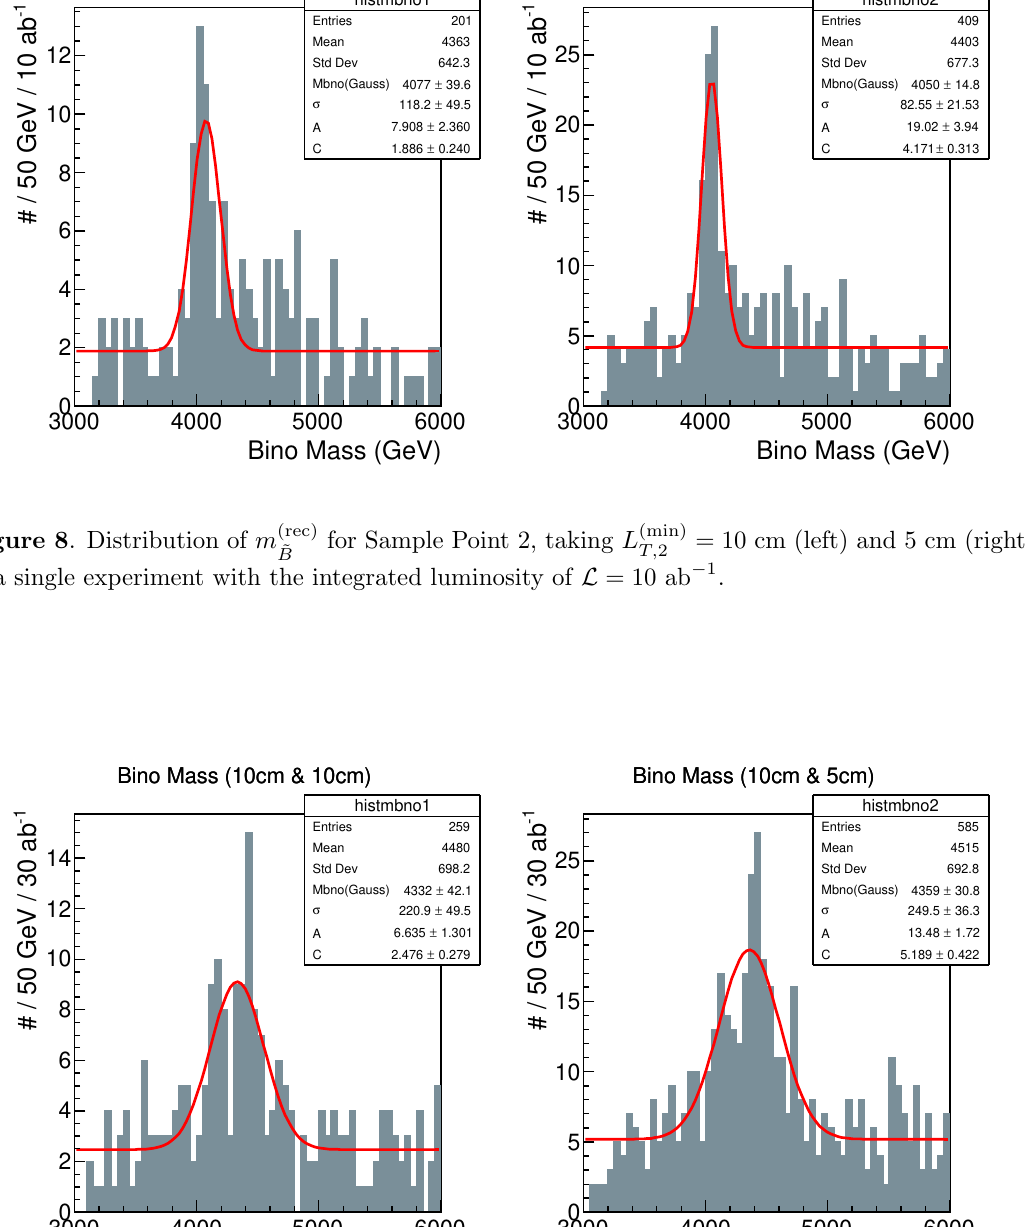
for Sample Point 3, taking L (min) ~ B